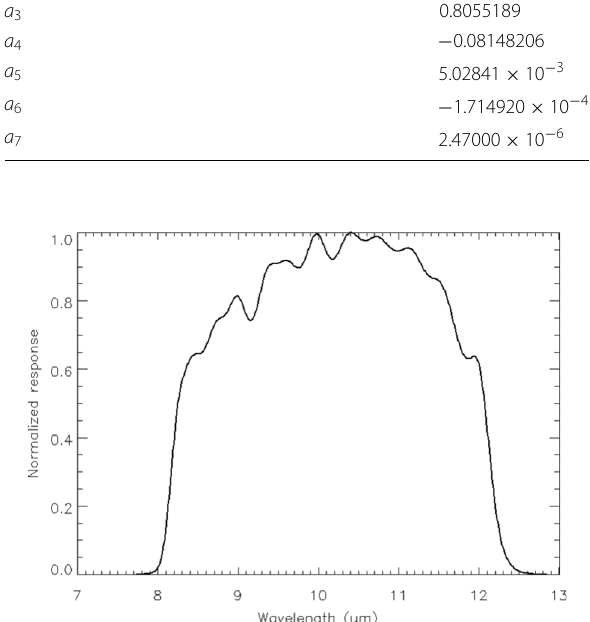
Fig. 6 Normalized LIR’s response as a function of wavelength